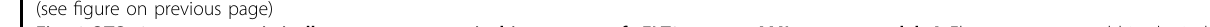
Fig. 6 OTS167 acts synergistically to promote survival in a xenograft FLT3 mutant AML mouse model. A Flow cytometry and histological analysis of bone marrow and spleen from representative NSG mice engrafted with MV4:11 (hCD45 + ). (3 biological replicates for fl ow analysis, 1 biological replicate for histology). B Flow cytometry and histological analysis of bone marrow and spleen from representative NSG mice engrafted with MV4:11 (hCD45 + ) after 14 days of indicated treatment. (3 biological replicates for fl ow analysis, 1 biological replicate for histology) Graphs show the ratio of hCD45 + /mCD45 + cells in bone marrow and spleen of NSG mice engrafted with MV4:11 based on fl ow cytometry analysis (from Fig. 6B). (3 biological replicates). C Flow cytometry analysis of bone marrow and spleen from NSG mice engrafted with MV4:11 (hCD33 + ) and treated (starting d10 via oral gavage) with vehicle (0.5% methylcellulose), OTS167 or gilteritinib at indicated doses. Graphs show arithmetic mean intensity of surface FLT3 staining (3 biological replicates (mice) per treatment group). D Survival analysis of MV4:11-engrafted NSG mice (N = 8 – 9 per group) treated (starting d10 via oral gavage) with vehicle (0.5% methylcellulose), OTS167, gilteritinib or OTS167, and gilteritinib at indicated doses. (8 – 9 biological replicates (mice) per treatment group). E Survival analysis of MOLM-14-engrafted NSG mice ( N = 10 per group) treated (starting d7 via oral gavage) with vehicle (0.5% methylcellulose), OTS167, gilteritinib or OTS167 and gilteritinib at indicated doses. (10 biological replicates (mice) per treatment group). Histology images are ×500 (×10 ocular, ×50 objective). (**** P < 0.0001, *** P < 0.001, * P <